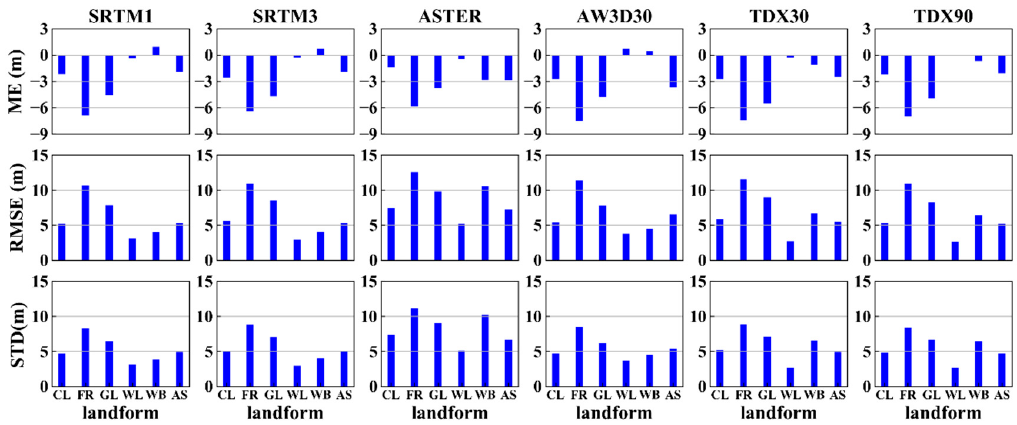
Figure 7. The error statistics in different land cover classes: ME (top), RMSE (middle) and STD (bottom) values of different DEMs. CL: cultivated land, FR: forest, GL: grassland, WL: wetland, WB: water body, AS: artificial surfaces.